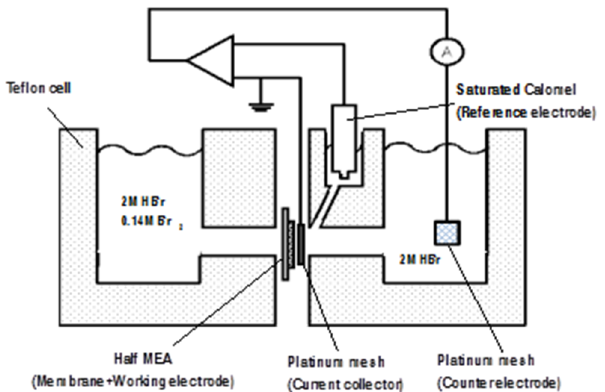
Figure 2. Schematic diagram of the two compartment apparatus for determining membrane diffusion coefficients.